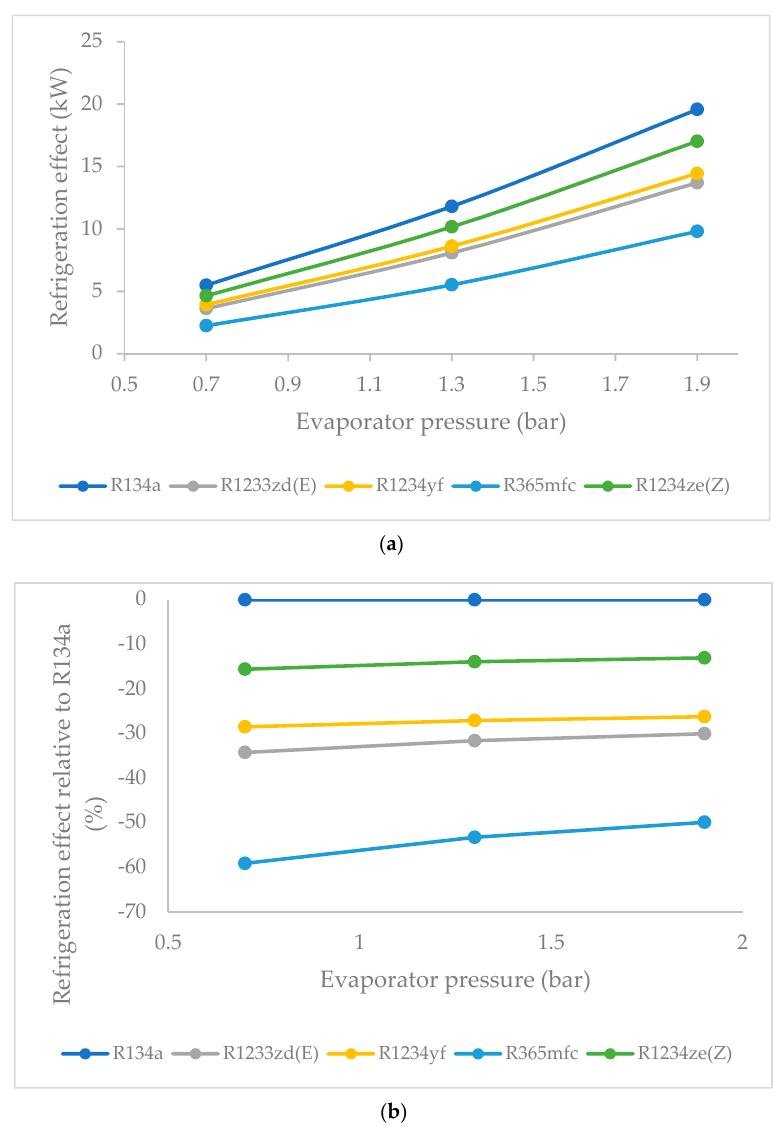
Figure 7. ( a ) Refrigeration effect as a function of evaporator pressure (condenser pressure = 9 bar). ( b ) Refrigeration effect relative to R134a (condenser pressure = 9 bar).